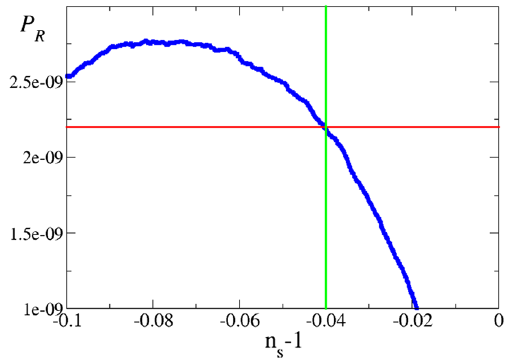
Fig. 5 Amplitude of the spectrum of perturbations versus the tilt with = 10 − 1 . 41 M = 1.Thebluelineisthe λ = 10 − 2 , N = 10 5 . 5 ,ϕ P and g 0 simulation (average over 10 4 realisations) and the green and red lines are the cosmologically observed value of the spectrum and amplitude of pertubations respectively